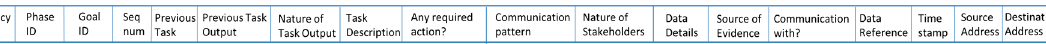
Figure 8. Local Token Template.